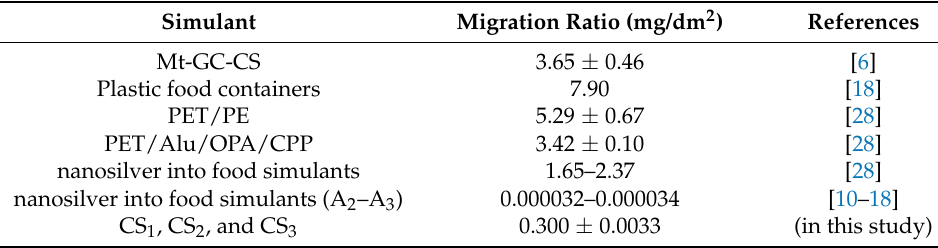
Table 4. According to the literature of migration analysis results.